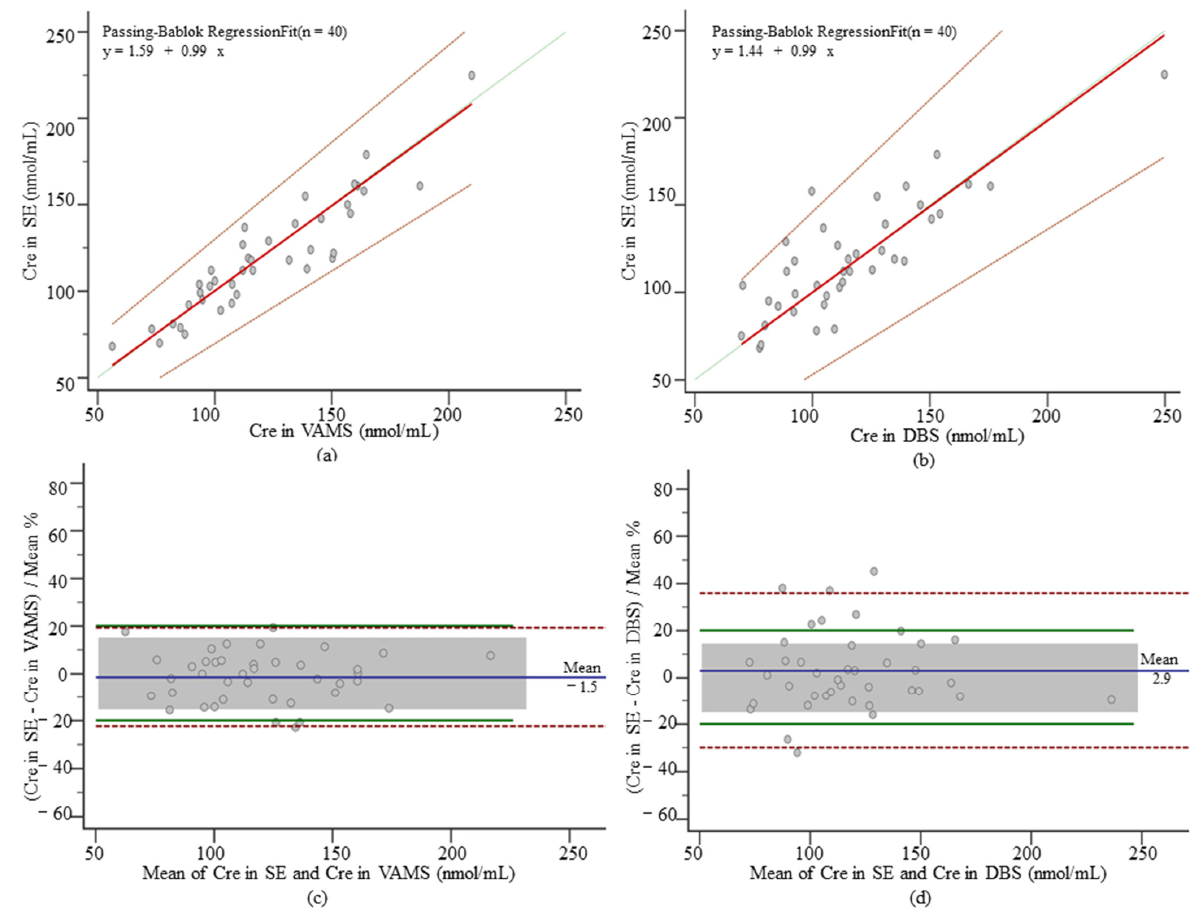
Figure 5. PB regression and Bland–Altman plot for Cre. ( a ) PB regression of corrected Cre concentra- tions in VAMS samples and serum samples, the solid red line is the regression line, the dashed red line is the 95% CI, and the solid green line is the identity; ( b ) PB regression of corrected Cre concen- trations in DBS samples and serum samples; ( c ) Bland–Altman plots of serum Cre concentrations and corrected VAMS serum concentrations. The blue solid line is the mean deviation, the red dashed line is the 95% CI, the green solid line is the APE acceptance limit ( ± 20%), and the grey box is the set clinical acceptance limit ( ± 15%), the following MPA and Cre as well; ( d ) Bland–Altman plots of serum Cre concentrations and corrected DBS serum